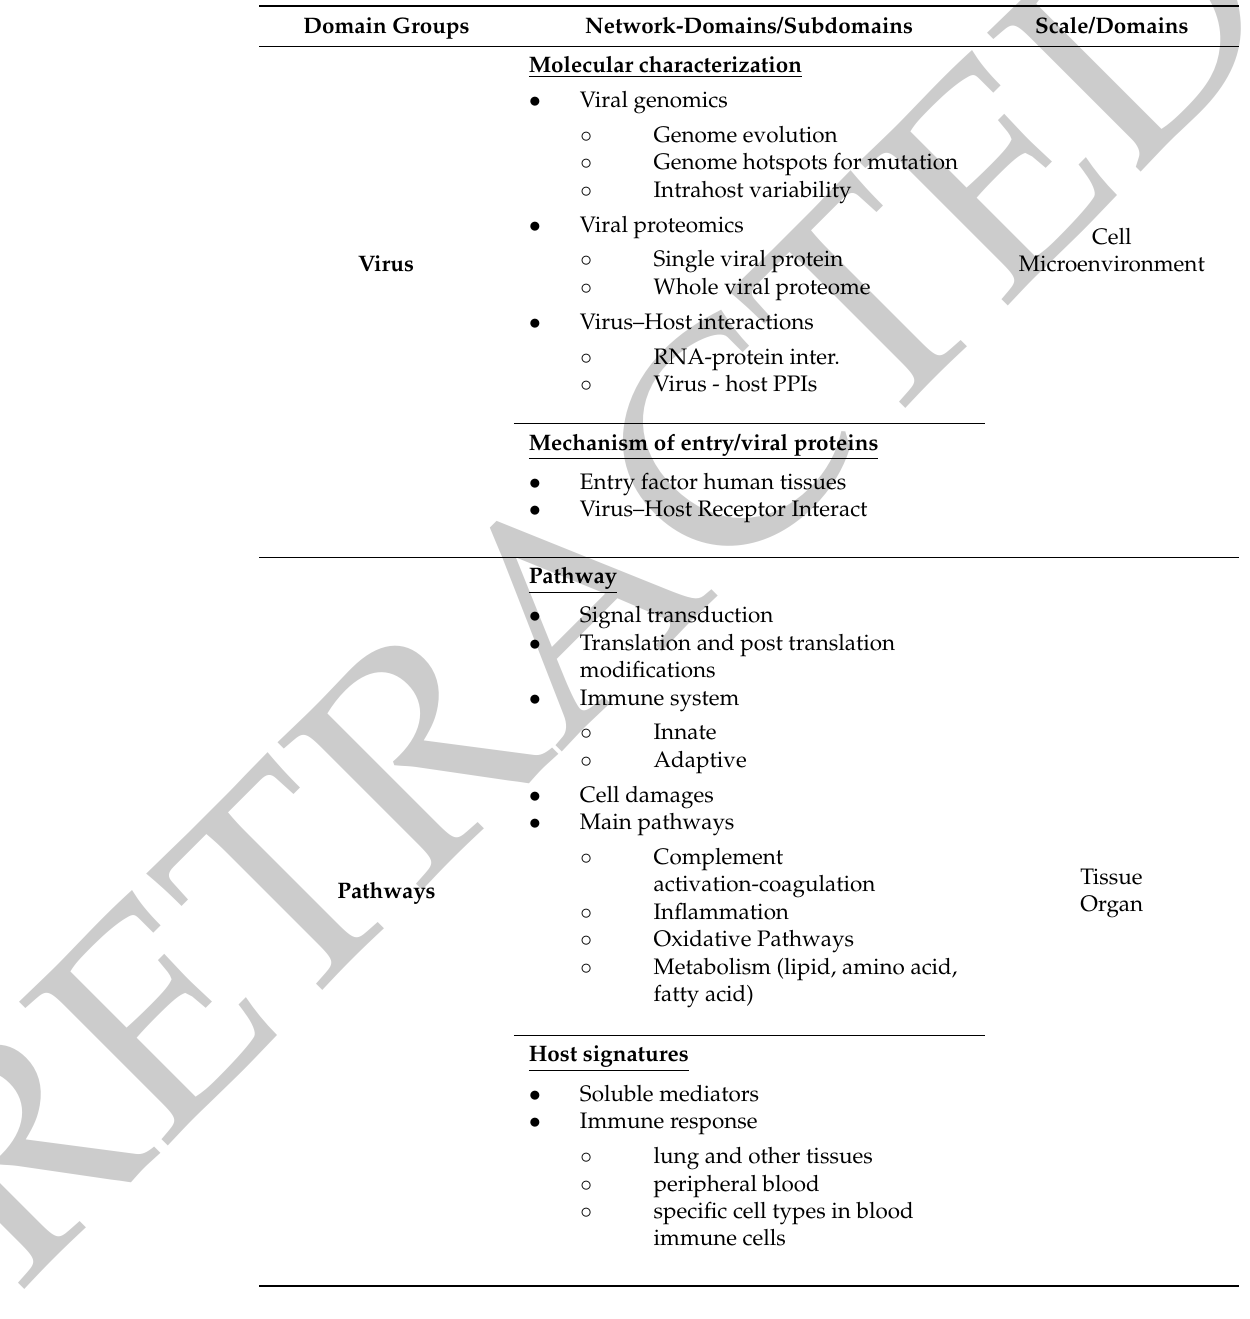
Table 1. Scoping review: multiomics approach and domains identification literature based. In columns the conceptual sub setting, descried in Montaldo and colleagues, are reported: domain groups, wide conceptual category; domain, subdomain, and function (in bold and underlined, black dot and empty dot, respectively); scale of